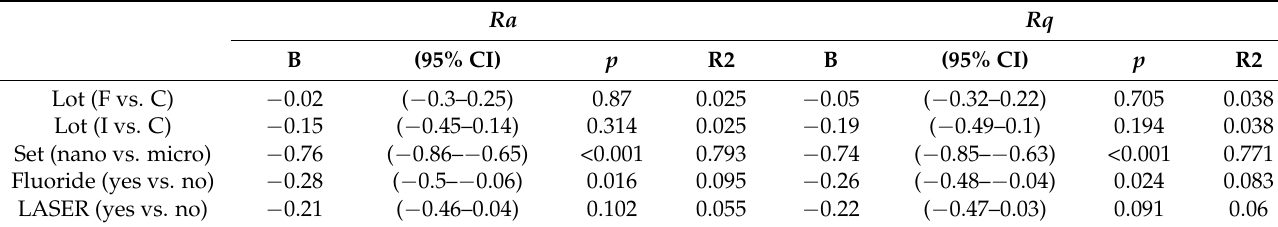
Table 3. Robust univariate submodels’ generation.